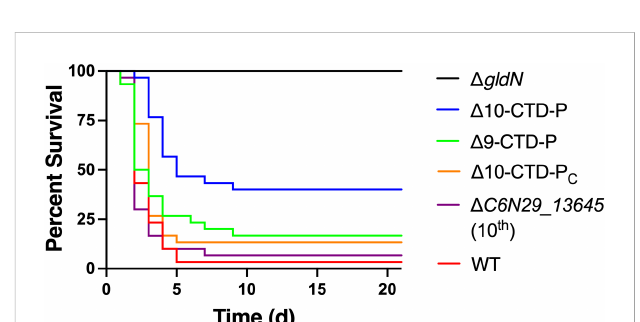
FIGURE 6 Effect of deletion of peptidase-encoding genes on virulence of F. columnare in juvenile rainbow trout. Rainbow trout were exposed by immersion to wild-type and mutant strains and survival was monitored for 21 days. Strains examined were wild-type F. columnare (WT); D gldN ; D 10-CTD-P; D 9-CTD-P; D C6N29_13645; D 10-CTD-P complemented by chromosomal insertion of C6N29_13645 ( D 10-CTD-P C ). The fi nal challenge concentrations were 7.6 × 10 6 CFU/mL (WT), 9.3 × 10 6 CFU/ mL ( D gldN ), 7.1 × 10 6 CFU/mL ( D 10-CTD-P), 7.3 × 10 6 CFU/mL ( D 9- CTD-P), 7.6 × 10 6 CFU/mL ( D C6N29_13645), and 5.4 × 10 6 CFU/mL ( D 10-CTD-P C ). Signi fi cant differences in percent survival for fi sh challenged were observed between the WT and D 10-CTD-P ( P <0.0001).